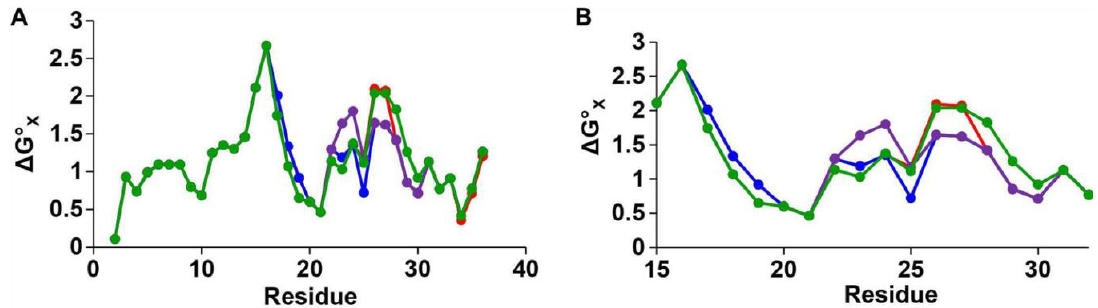
Figure 6. Hydrophobicity plots for hIAPP (red), r-IAPP (green), and a triple mutated version of hIAPP with substitutions at H18R, G14P, and I26P, which is non-toxic (TM-IAPP) (purple), and I26P-IAPP (blue), which is a substitution in hIAPP that is known to change aggregation propensity. Panel ( A ) describes the full sequence of IAPP, while panel ( B ) shows the key region of interest (residues 16 to 32). The vertical axis is residue solvation free energy as calculated from an octanol-to-water partition scale with mole-fraction units with glycine set to zero. Larger positive values indicate increased hydrophobicity. Adapted from Abedini et al. [22]. Licensed under a Creative Commons Attribution (CC BY) license.